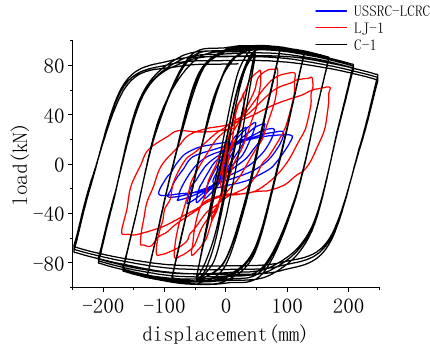
Figure 15. Comparison of the hysteresis curves of the three types of components.